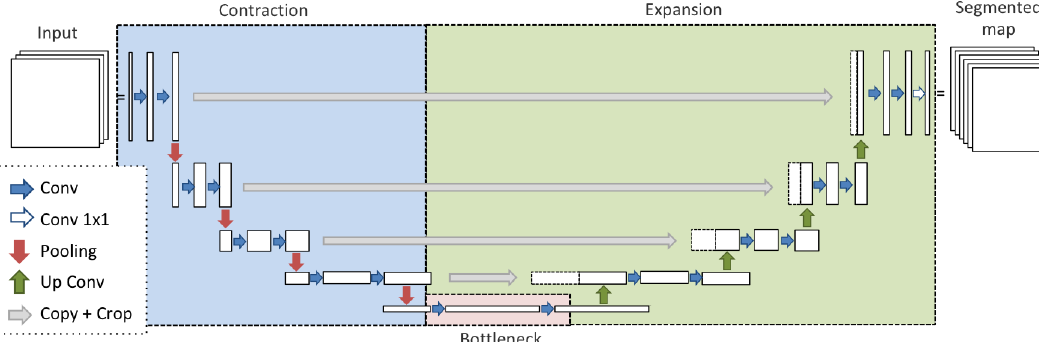
Figure 9. The U-Net model for semantic segmentation. The model is composed of three steps: Contraction with convolutional layers and max pooling, Bottleneck with a couple of convolutional layers and a drop-out, and Expansion with some deconvolutional and convolutional layers and feature map